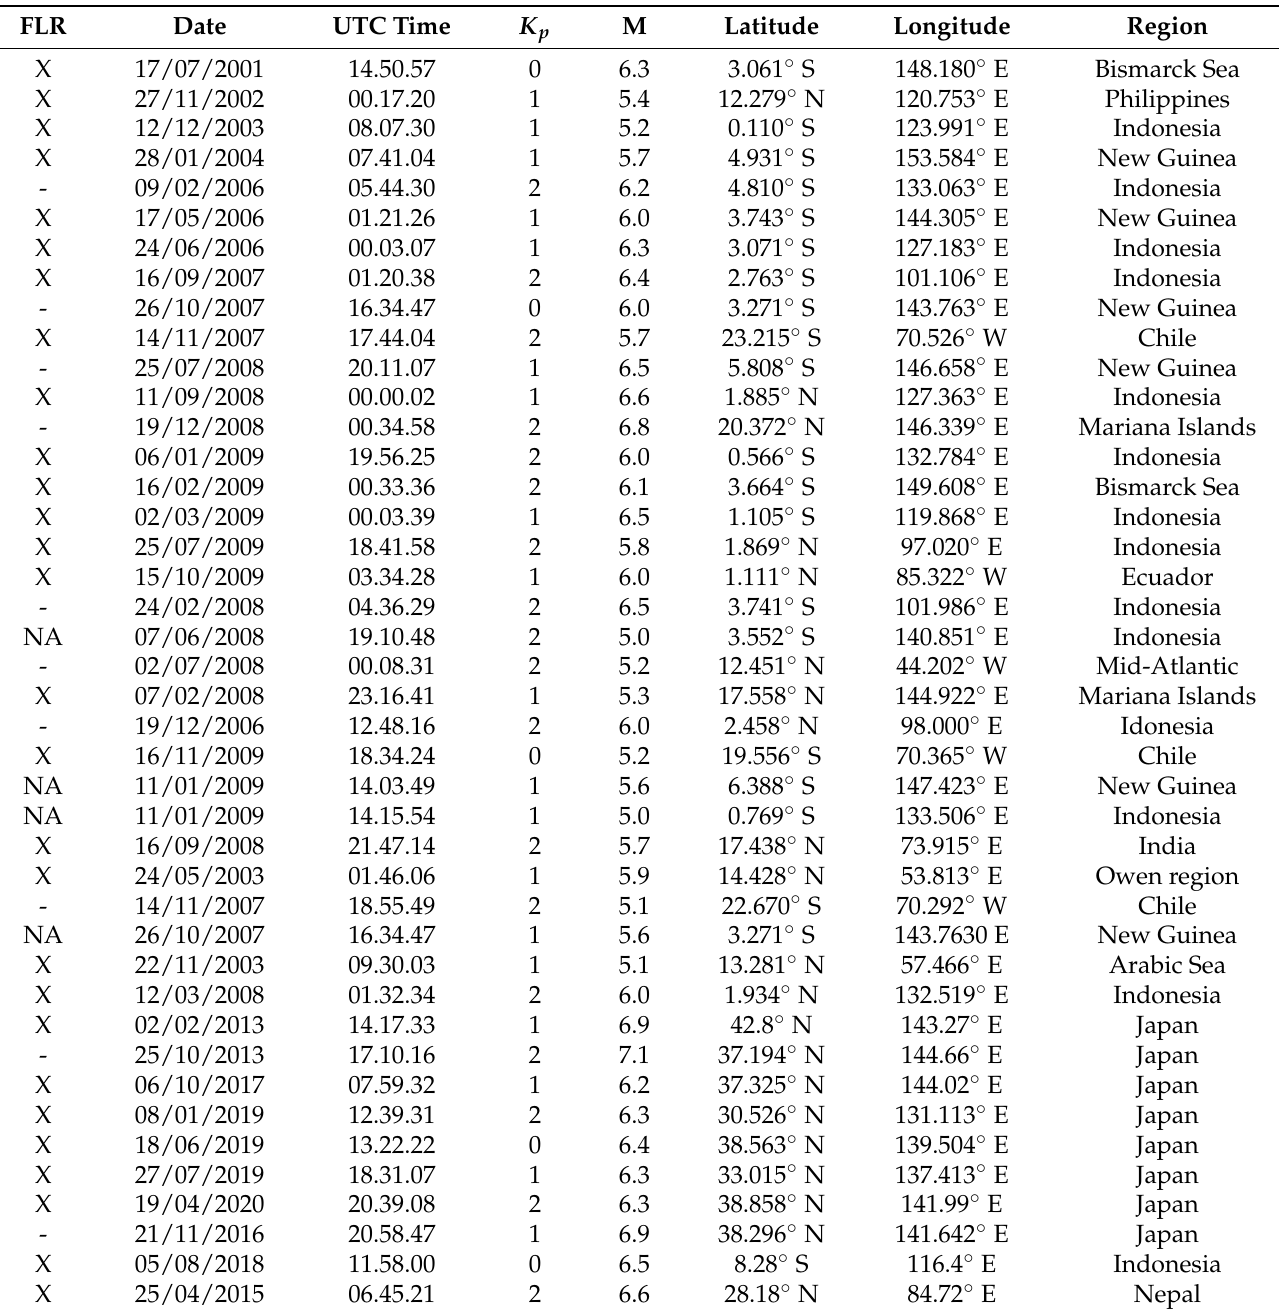
Table 1. Characteristics of the EQ events analyzed from 2001 to 2020. The X indicates a FLR eigenfrequency variation. The - indicates the absence of a FLR eigenfrequency variation. The NA indicates the impossibility to evaluate the FLR eigenfrequency. M is the earthquake magnitude. The parameters of the earthquake are provided by USGS data